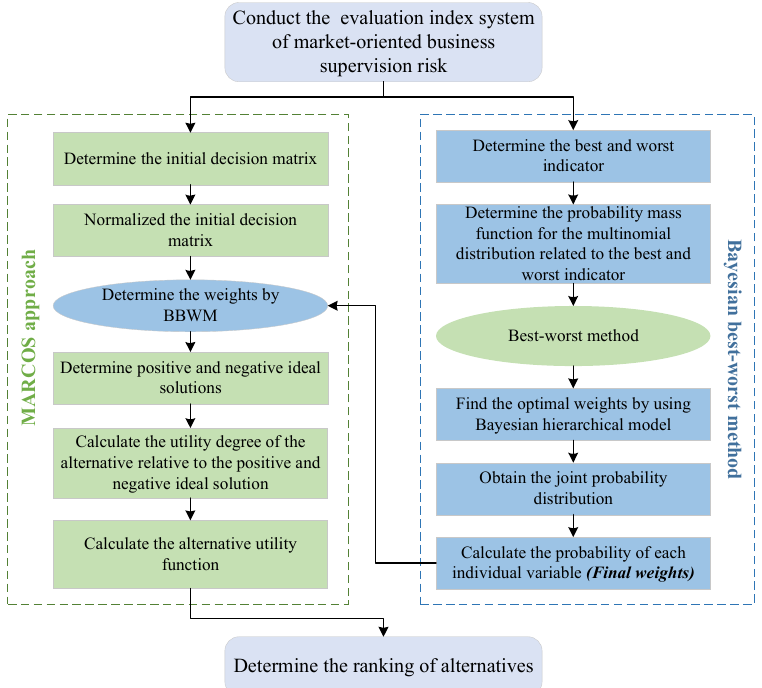
Figure 2. The framework of the proposed